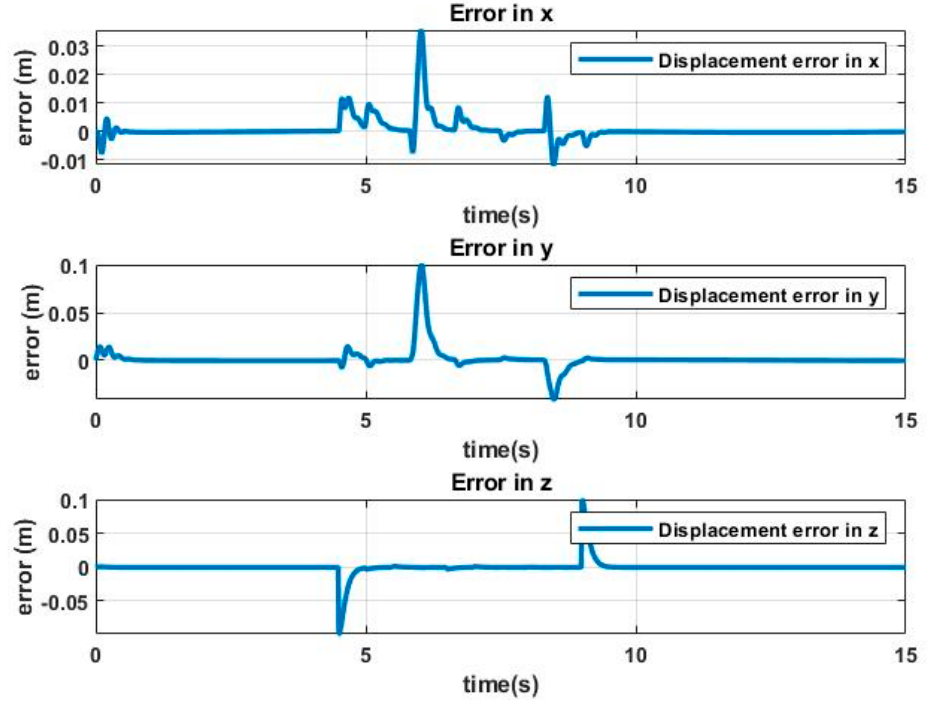
Figure 18. Relative displacement errors vs. time from task with perturbance.